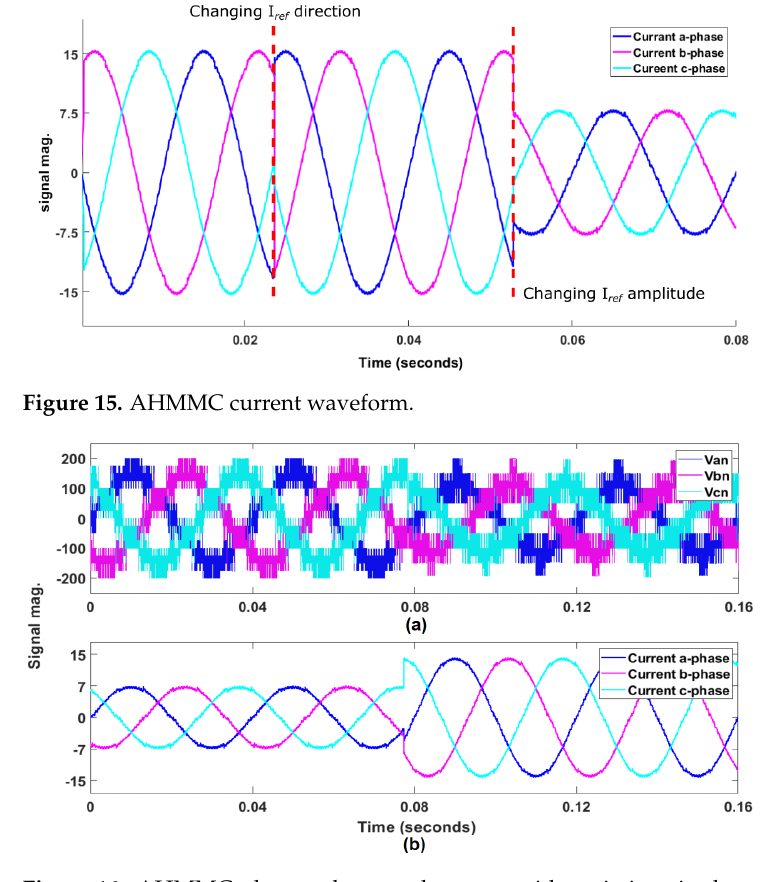
Figure 16. AHMMC phase voltage and current with variations in the power transfer: ( a ) phase voltages, ( b ) converter